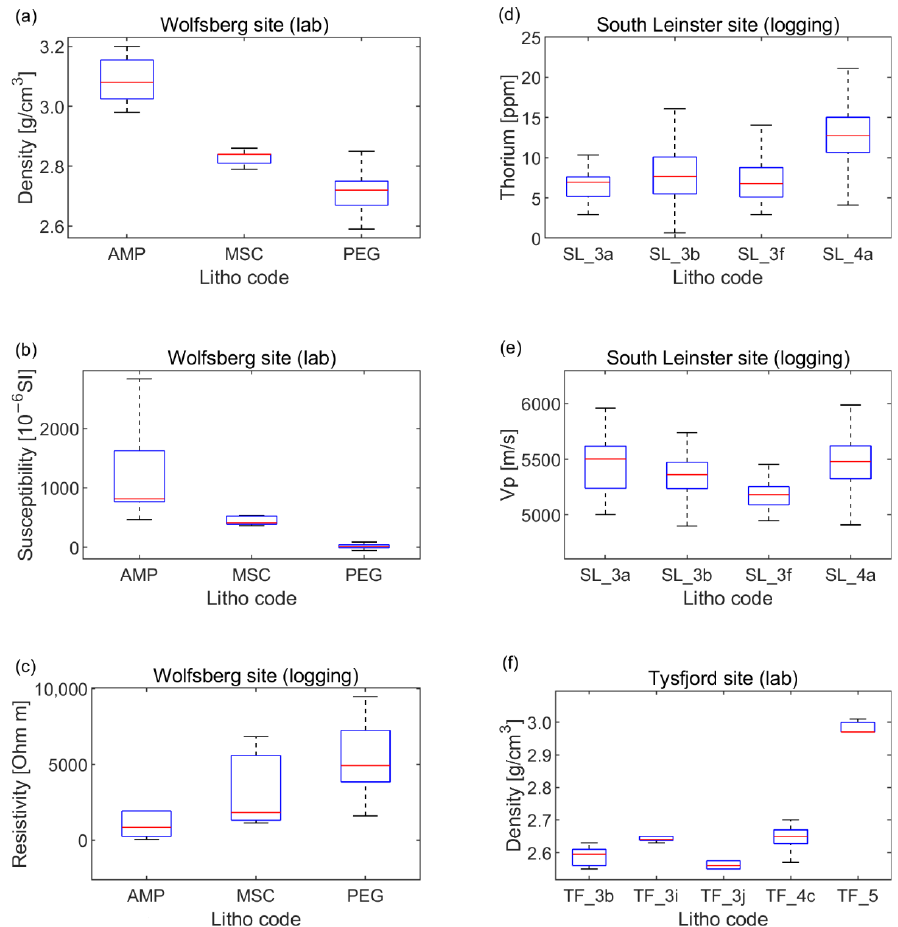
Figure 9. Selected examples from the database visualized as boxplots. Within each box, the central, red mark indicates the median. The top and bottom of the box indicate the 25th and 75th percentile, respectively. Extreme data points are indicated by the whiskers; outliers were removed. ( a – c ) Data examples from the Wolfsberg site in Austria. ( d – e ) Examples from borehole logging data from the Irish site in South Leinster. ( f ) Data example from the Tysfjord site in Norway. Properties are plotted against the lithology codes used in the database (general and detailed): AMP: Amphibolite, MSC: Mica schist, PEG: Pegmatite. SL: South Leinster, TF: Tysfjord, 3a: Spodumene pegmatite, 3b: Simple (granitic) pegmatite, 3f: Albitized pegmatite, 3i: Quartz pegmatite, 3j: Feldspar pegmatite, 4a: Porphyritic granite, 4c: Metagranite, 5: Amphibolite. The full list of codes is given in the database itself